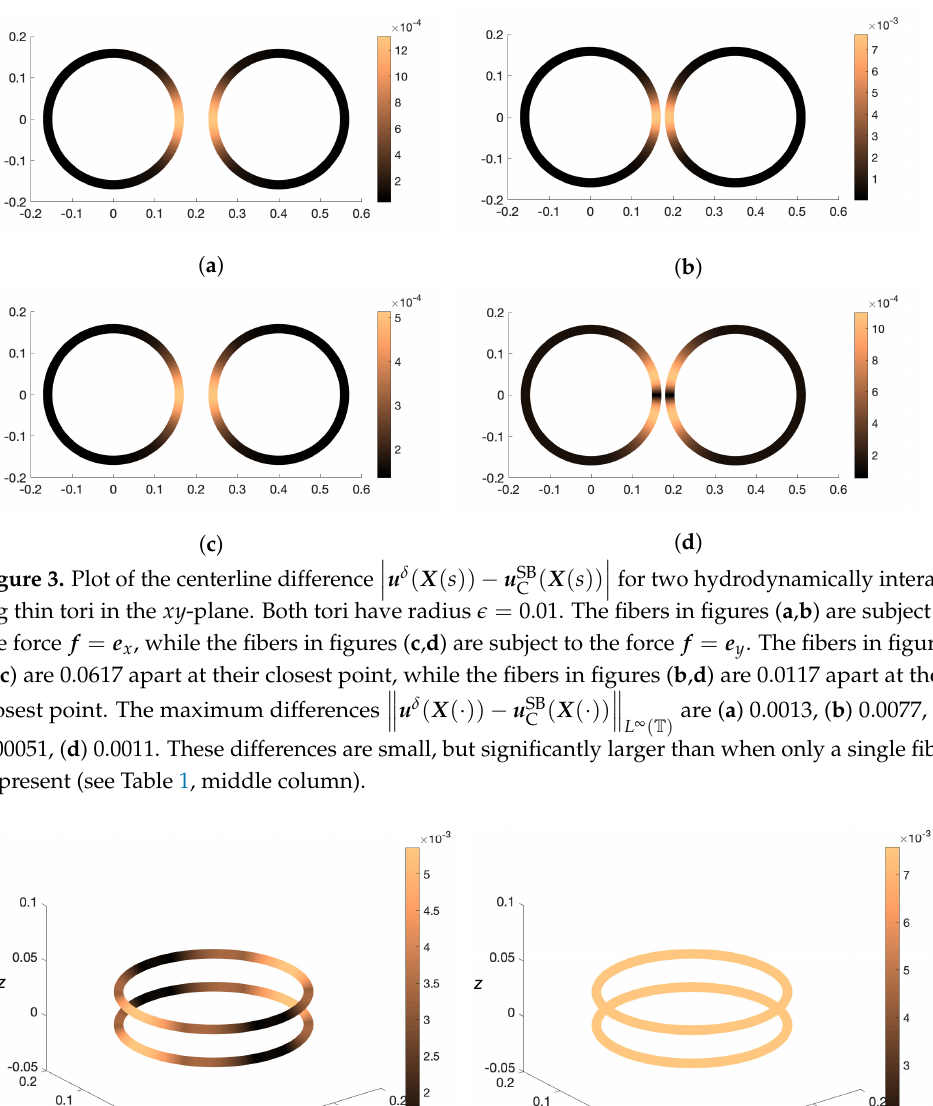
(cid:12) (cid:12) (cid:12) (cid:12) δ ( X ( s )) − u SB ( X ( s )) (cid:12) u (cid:12) for two hydrodynamically inter- C